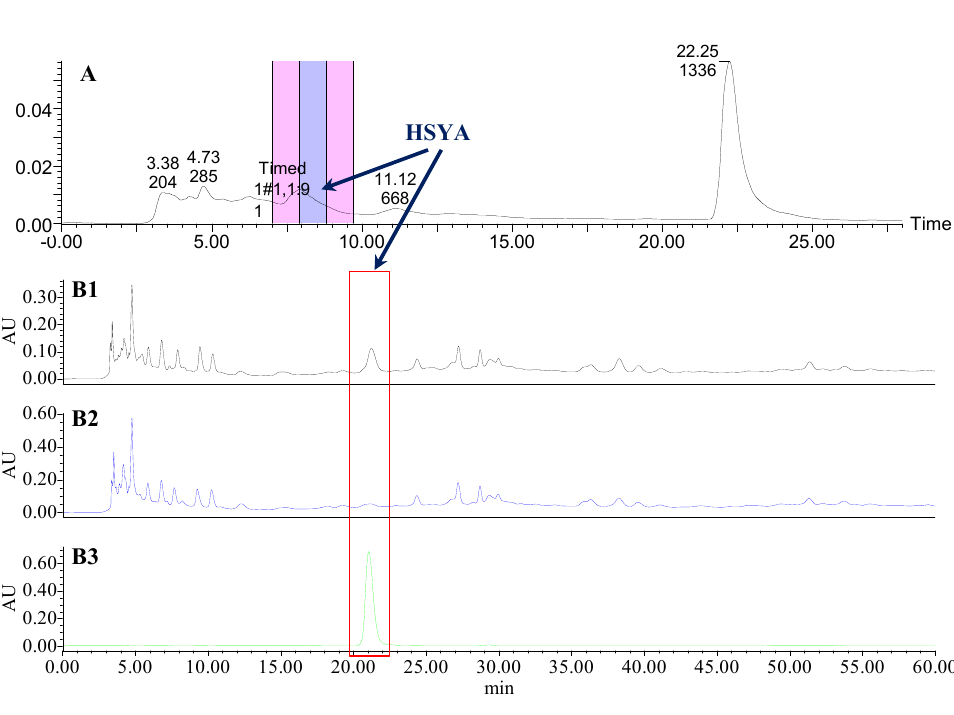
Figure 3. The preparative and analytical chromatograms of the depletion of HSYA from CF-AS; ( A ) preparative chromatogram at 270 nm; ( B1 ) analytical chromatogram of CF-AS at 270 nm; ( B2 ) analytical chromatogram of CF-AS-A at 270 nm; ( B3 ) analytical chromatogram of HSYA depleted from CF-AS at 270 nm.